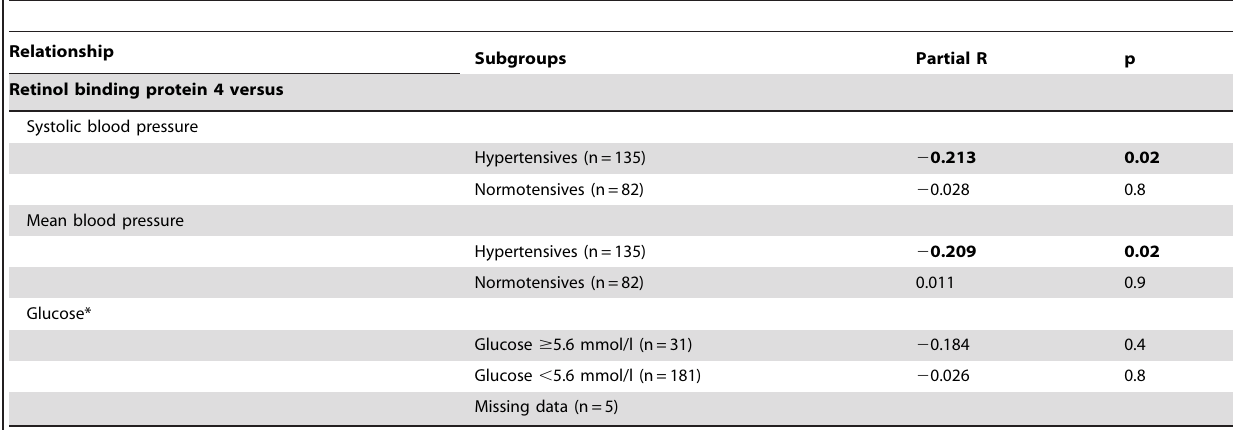
Table 4. Independent relationships of retinol binding protein 4 concentrations with systolic and mean blood pressure, and glucose levels amongst subgroups.